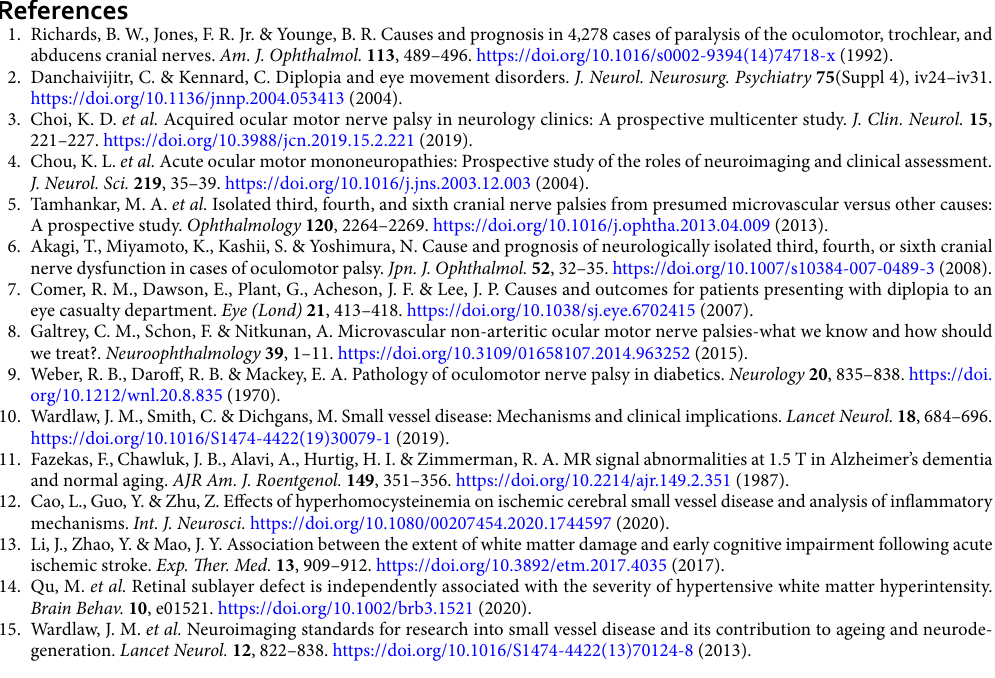
Table 6. A sensitivity analysis among patients without any of vascular risk factors (n = 144). Odds ratios of the imaging parameters were represented based on multivariate logistic regression analysis. In Models A and C, covariates were age, sex, diagnosis, body mass index (BMI), ischemic heart disease (IHD), estimated glomerular filtration rate (eGFR), prior use of antithrombotics, and MRI field strength (3 T vs. 1.5 T). In Model B, covariates were age, sex, diagnosis, BMI, IHD, eGFR, prior use of antithrombotics, and susceptibility sequence type [susceptibility weighted image (SWI) vs. T2*-weighted gradient echo (GRE)]. OCNPi ocular cranial nerve palsy of presumed ischemic origin, WMH white matter hyperintensities, CMBs cerebral microbleeds.